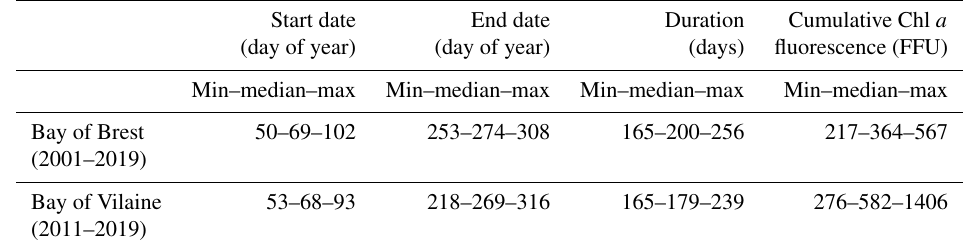
Figure 3. Example of detection of the start (red line) and end (blue line) of the phytoplankton growing period in 2001 at COAST-HF-Iroise. The threshold value – the median of slopes – is represented by a dotted grey line. Table 2. Global characteristics of the phytoplankton growing period in the Bay of Brest and in the Bay of